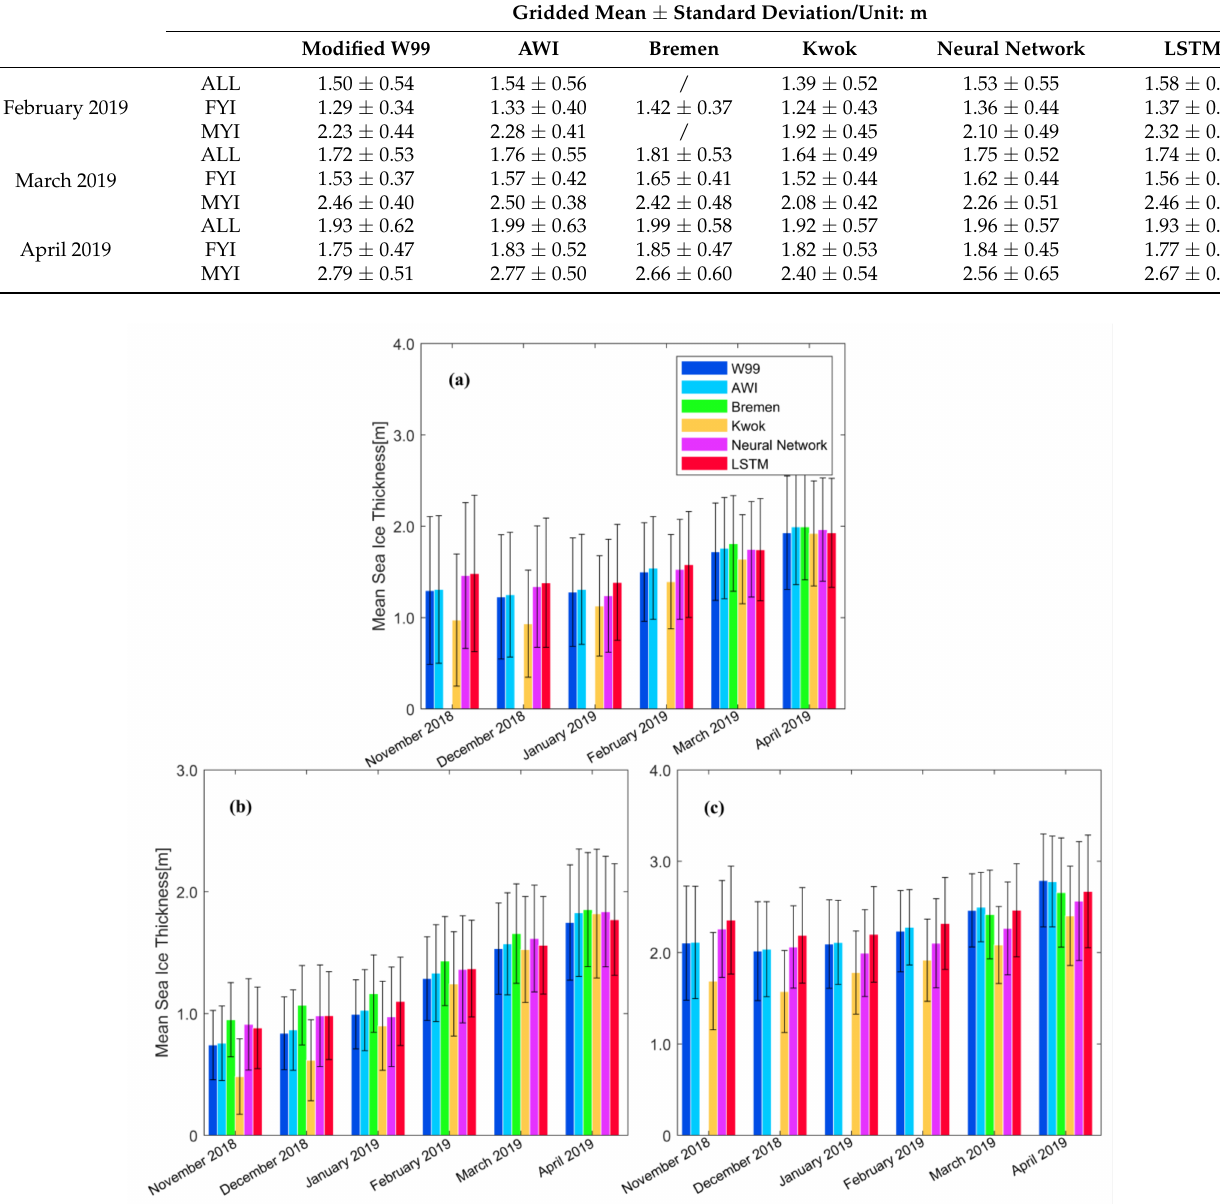
Figure 12. Histogram of seasonal variations in different SIT products: ( a ) total sea ice, ( b ) FYI and ( c ) MYI.